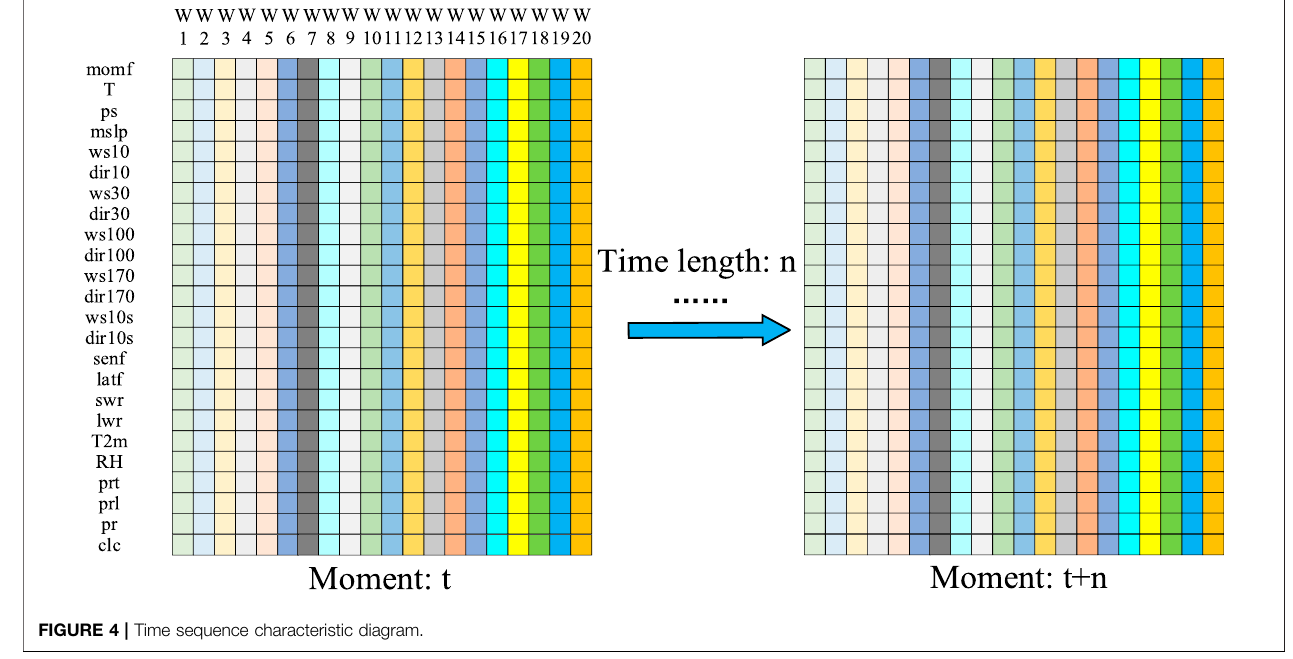
FIGURE 4 | Time sequence characteristic diagram.